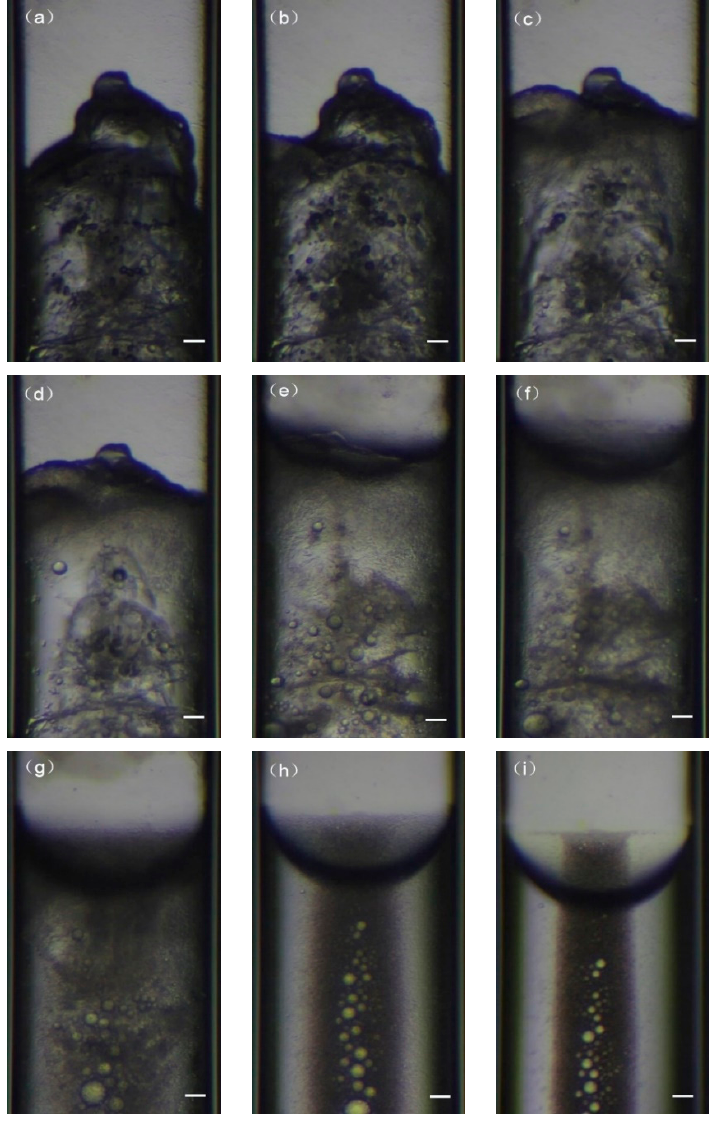
Figure 4. Snapshots of the CP–ice interface with an increase in temperature. The scale bars in the images correspond to 50 μ m.